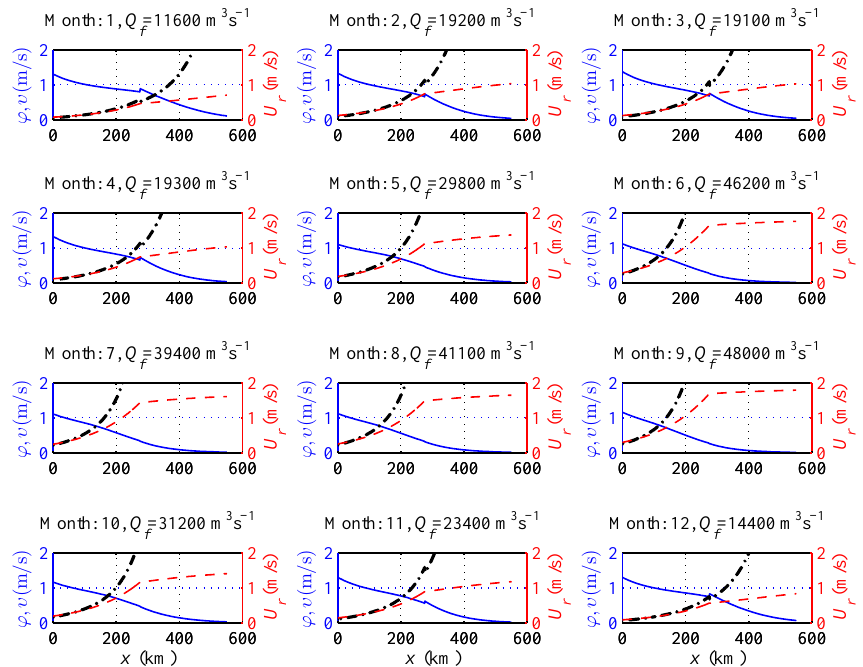
Figure 6. Longitudinal variation of the tidal velocity amplitude υ and river flow velocity U r along the Yangtze estuary in 2005. The dash- dotted line represents the ratio of the river flow velocity to the tidal velocity amplitude (i.e. the dimensionless river discharge term ϕ ).